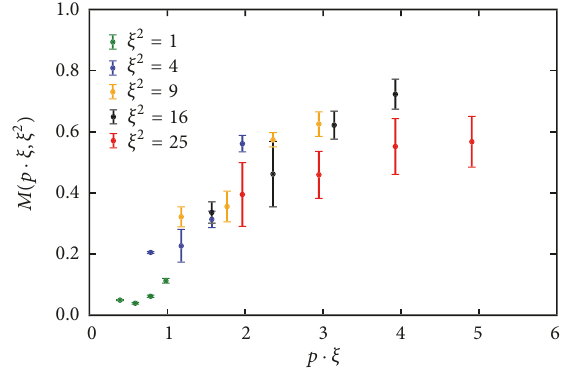
Figure 39: The vector-vector ( 𝛾 1 − 𝛾 1 ) current-current matrix element in a boosted pion state vs. the Ioffe time 𝑝 ⋅ 𝜉 ( 𝑝 is pion momentum and 𝜉 is separation of currents). Colors correspond to different separations 𝜉 2 in lattice units. These matrix elements can be factorized into the pion PDF. Source: [231], reprinted with permission by the